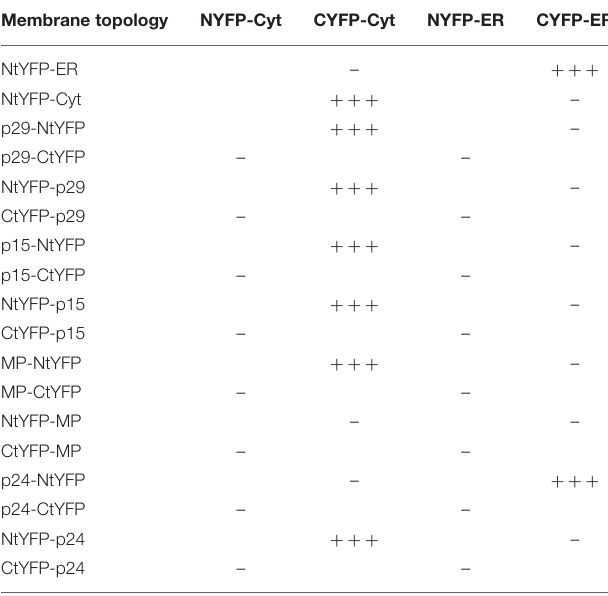
TABLE 3 | Synthesis of all protein pair combinations performed in the BiFC topology assay for p29, p15, MP, and p24 CiLV-C proteins. Membrane